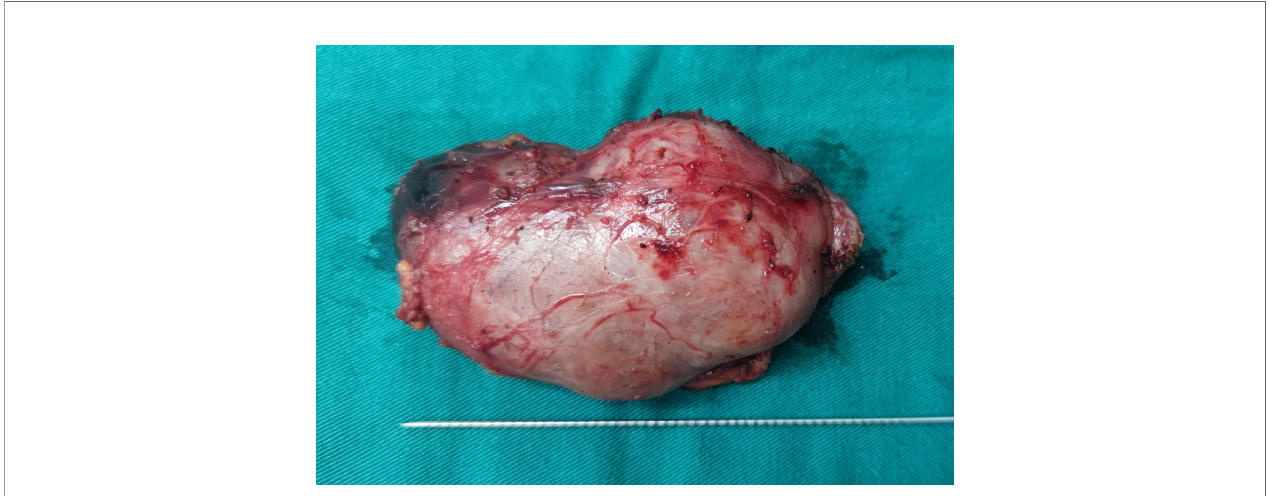
FIGURE 5 | The completely removed gross specimen of the right gland tumor of the patient (the distance between the scales was 2 mm in the fi gure).